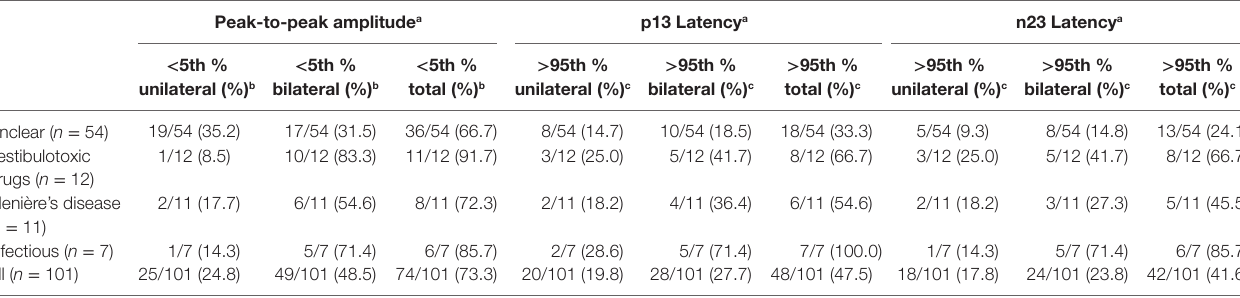
TaBle 5 | cVEMP amplitudes and